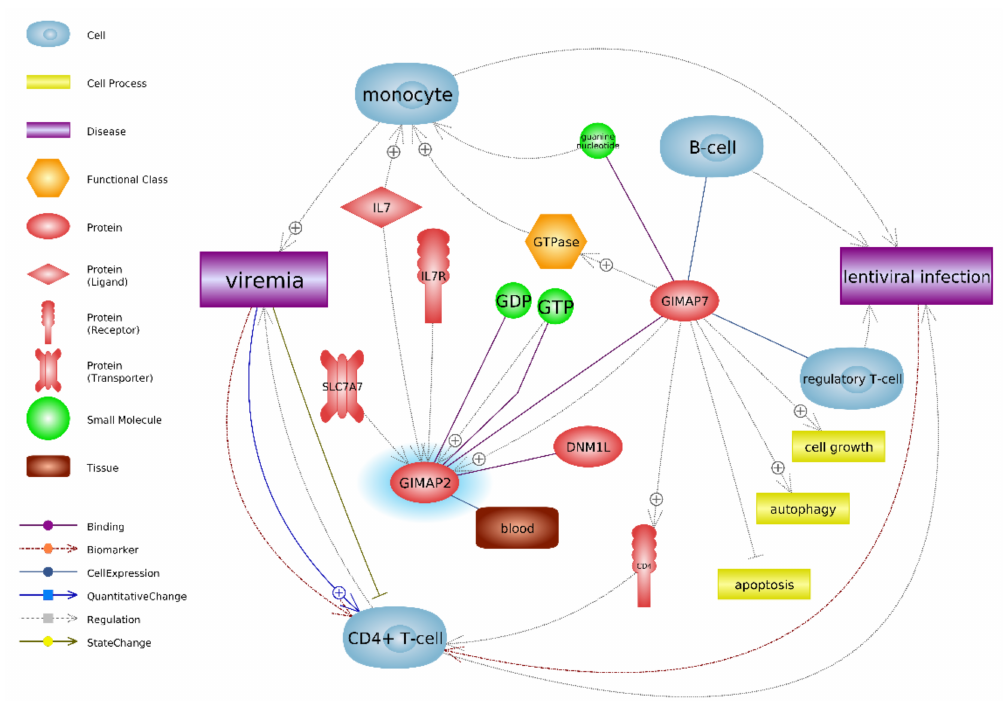
Figure 2. Interactions between proteins, cells, and lentiviral infection for the GIMAP2 gene in PBNCs, as analyzed by the Pathway Studio program [30]. Blue highlights upregulation in SRLV-SP goats vs. SRLV-SN goats; GIMAP2— GTPase, IMAP family member 2; GIMAP7—GTPase, IMAP family member 7 (GIMAP7 -> GIMAP2 can stimulate both its own GTPase activity and that of GIMAP2 by dimerization and the provision of a catalytic arginine finger); DNM1L— dynamin-1-like protein (gene encodes a member of the dynamin superfamily of GTPases); SLC7A7—solute carrier family 7 member 7 (regulates 11 gene expression signature genes, including GIMAP2, IL10RA, and IL18as); IL7R—interleukin 7 receptors (->Regulation IL7R->GIMAP2; the signal given by IL-7/IL-7R affects the regulation of apoptosis, cell cycle progression, and differentiation, cell type CD4 + T cell); GDP—guanosine diphosphate; GTP—guanosine triphosphate; IL7—interleukin 7; CD4 + T-cell—T-cell surface glycoprotein CD4 precursor (this gene encodes a membrane glycoprotein of T lymphocytes that interacts with major histocompatibility complex class II antigens and is also a receptor for the human immunodeficiency